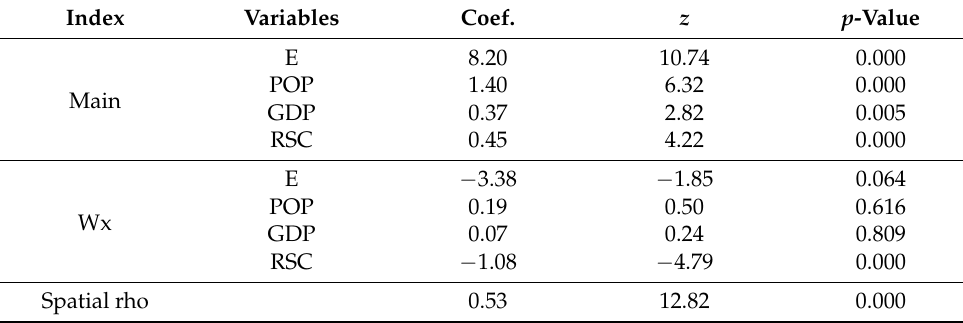
Table 3. Regression results of spatial Durbin